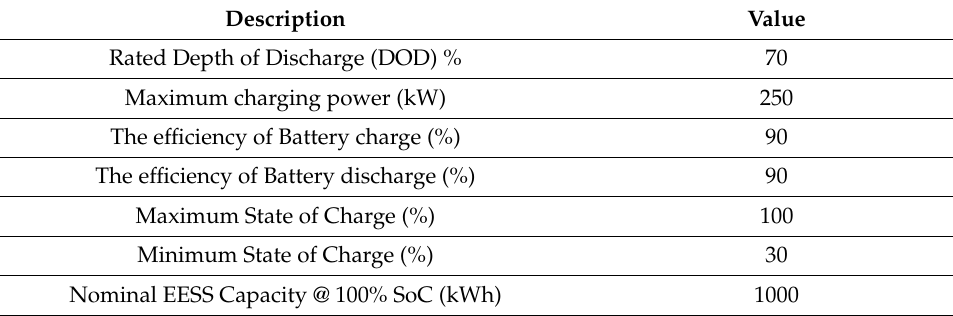
Table 4. Characteristics of the Lithium-Ion BESS Package.